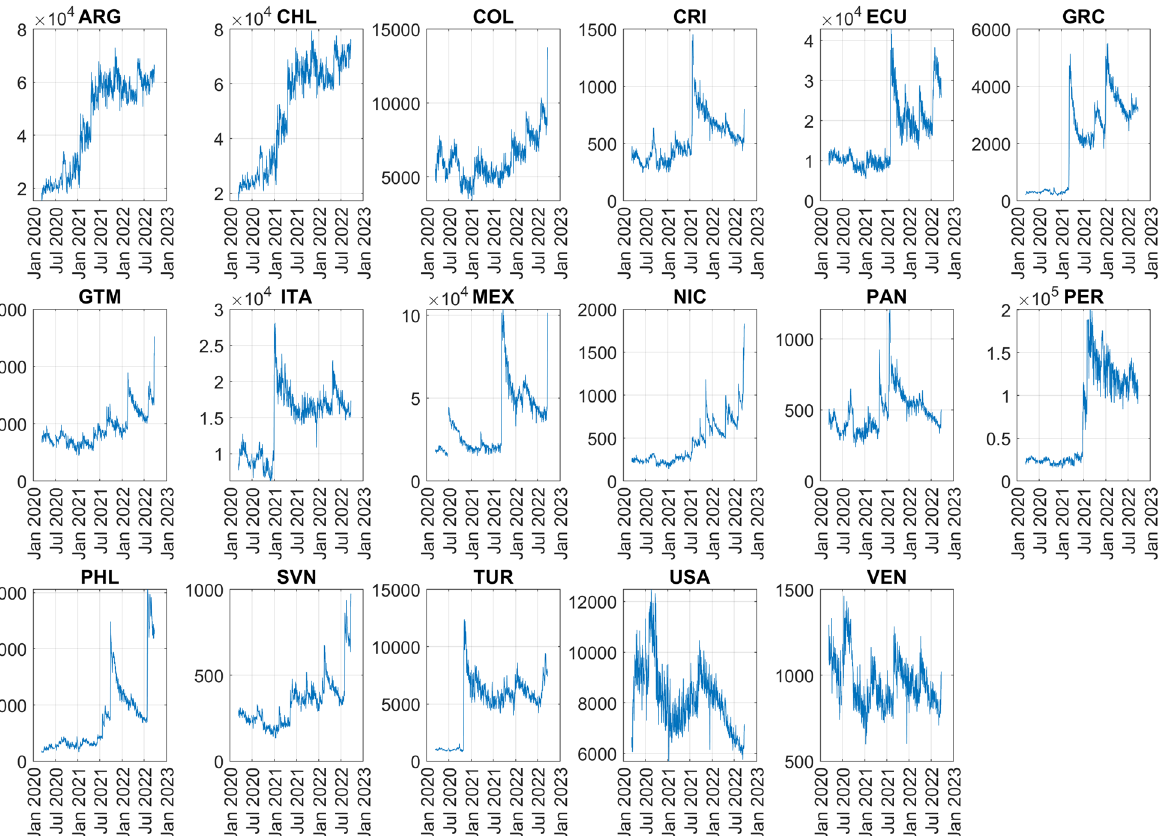
Figure 4. Time series of the number of daily smartphone trajectories used to estimate M 1 and M 2 metrics by